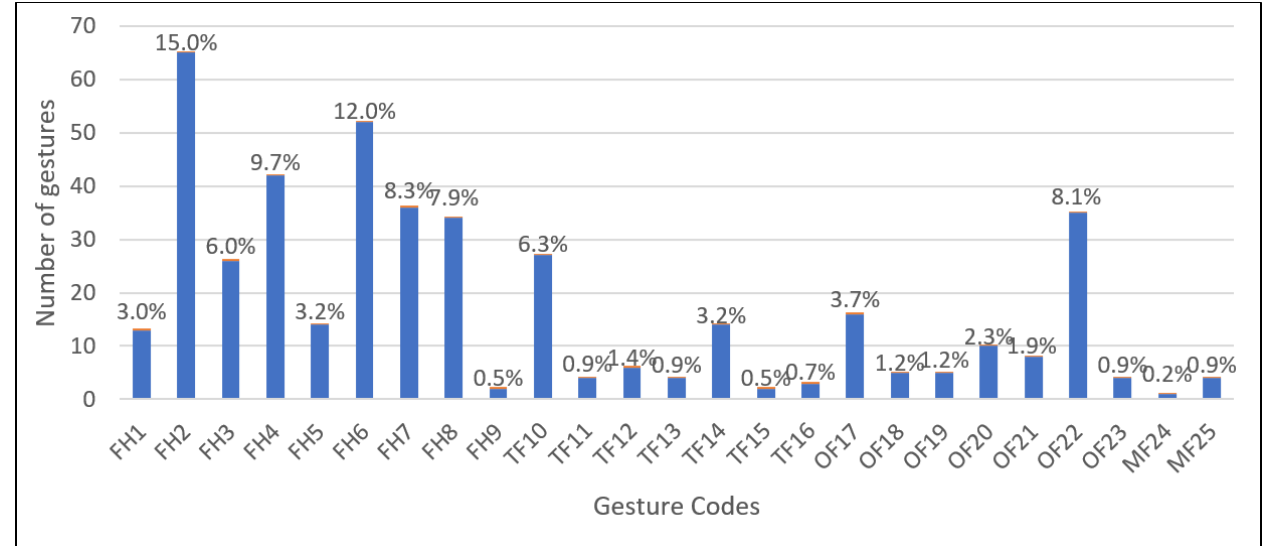
Figure 5. Gesture taxonomy breakdown using HomeG.